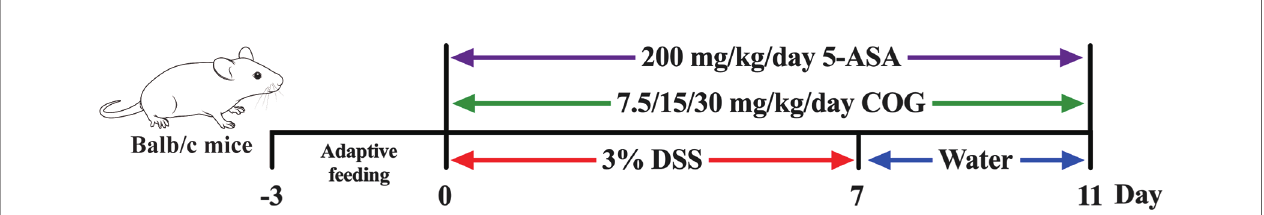
FIGURE 1 | Colitis induction and Chimonanthus nitens Oliv. leaf granule (COG)